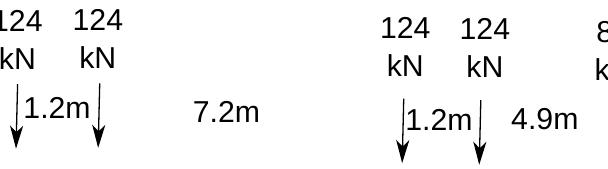
Figure 8. Factored axle loads acting on a beam from the 1-2-2